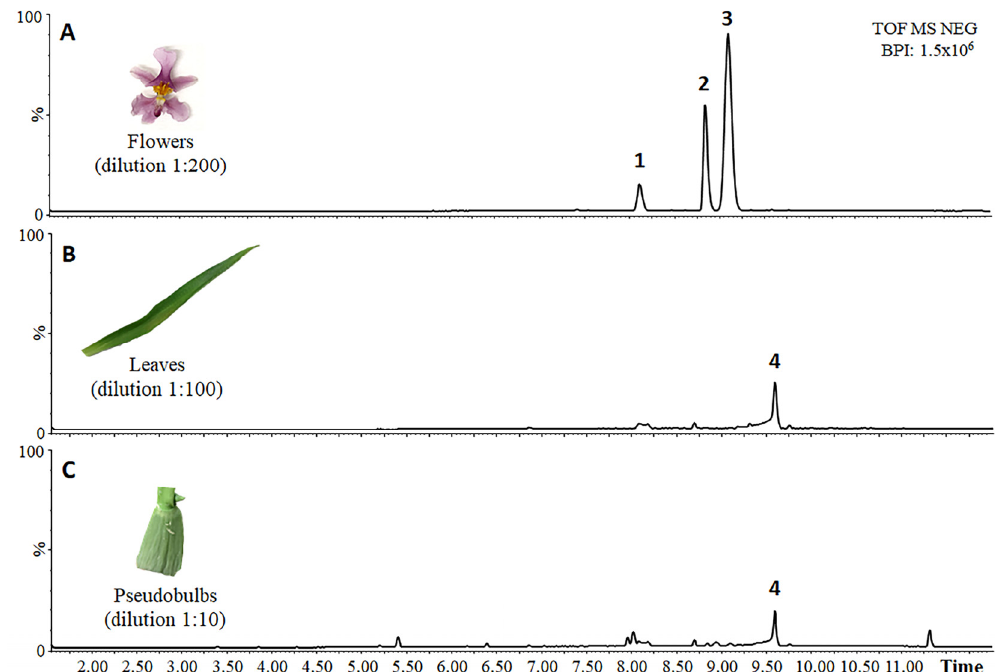
Figure 1. Negative base peak ion chromatograms of diluted O. sotoanum flower, leaf and pseudobulb extracts. ( A ) Base peak chromatogram of a flower extract diluted 1:200 (v/v) and 0.5 µ L injected to the LC-HRMS. Peaks numbers stand for a putative chrysin C-(acetyldeoxyhexosyl) hexoside (peak 1) and two putative isoforms of chrysin C-(diacetyldeoxyhexosyl) hexoside (peak 2 and 3). ( B ) Base peak chromatogram of a leaf extract diluted 1:100 (v/v) and 1 µ L injected to the LC-HRMS. Peak 4 indicates a putative chrysin C-(triacetyldeoxyhexosyl) hexoside-O-hexoside. ( C ) Base peak chromatogram of a pseudobulb extract diluted 1:10 (v/v) and 1 µ L injected to the LC-HRMS.